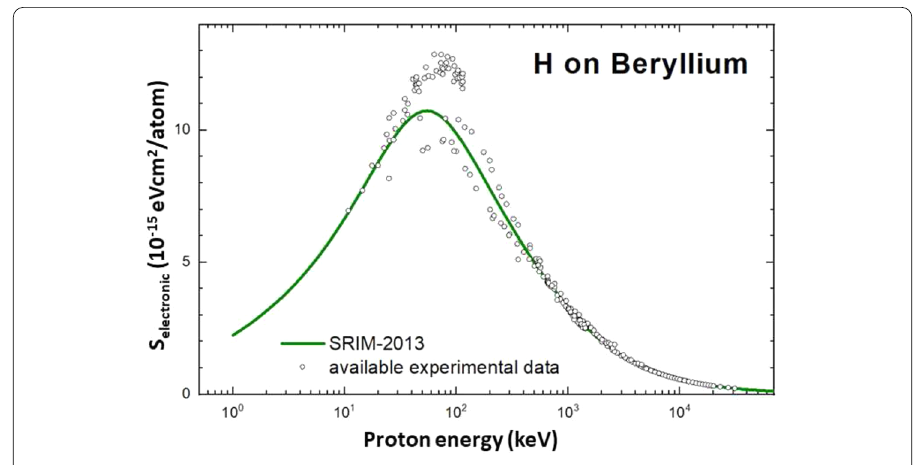
Figure 6 Data availability of experimental reference electronic stopping cross-sections for hydrogen on beryllium